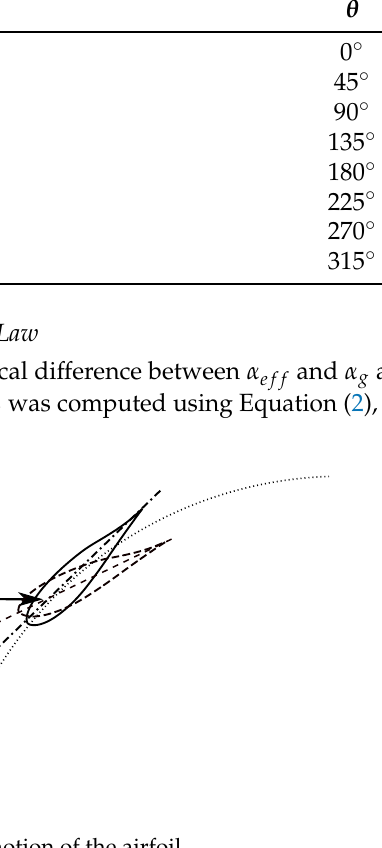
Figure 6. Pitching motion of the airfoil. Table 4. Values of α g at the eight azimuthal